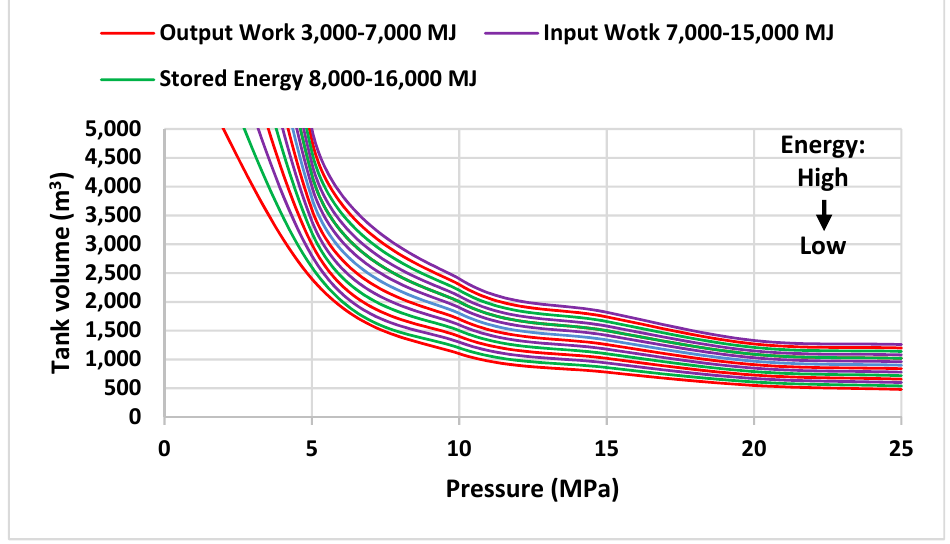
Figure 16. Changes in tank volume with pressure for α value equal to 0.25 for input work, output work, and stored energy, and different stored